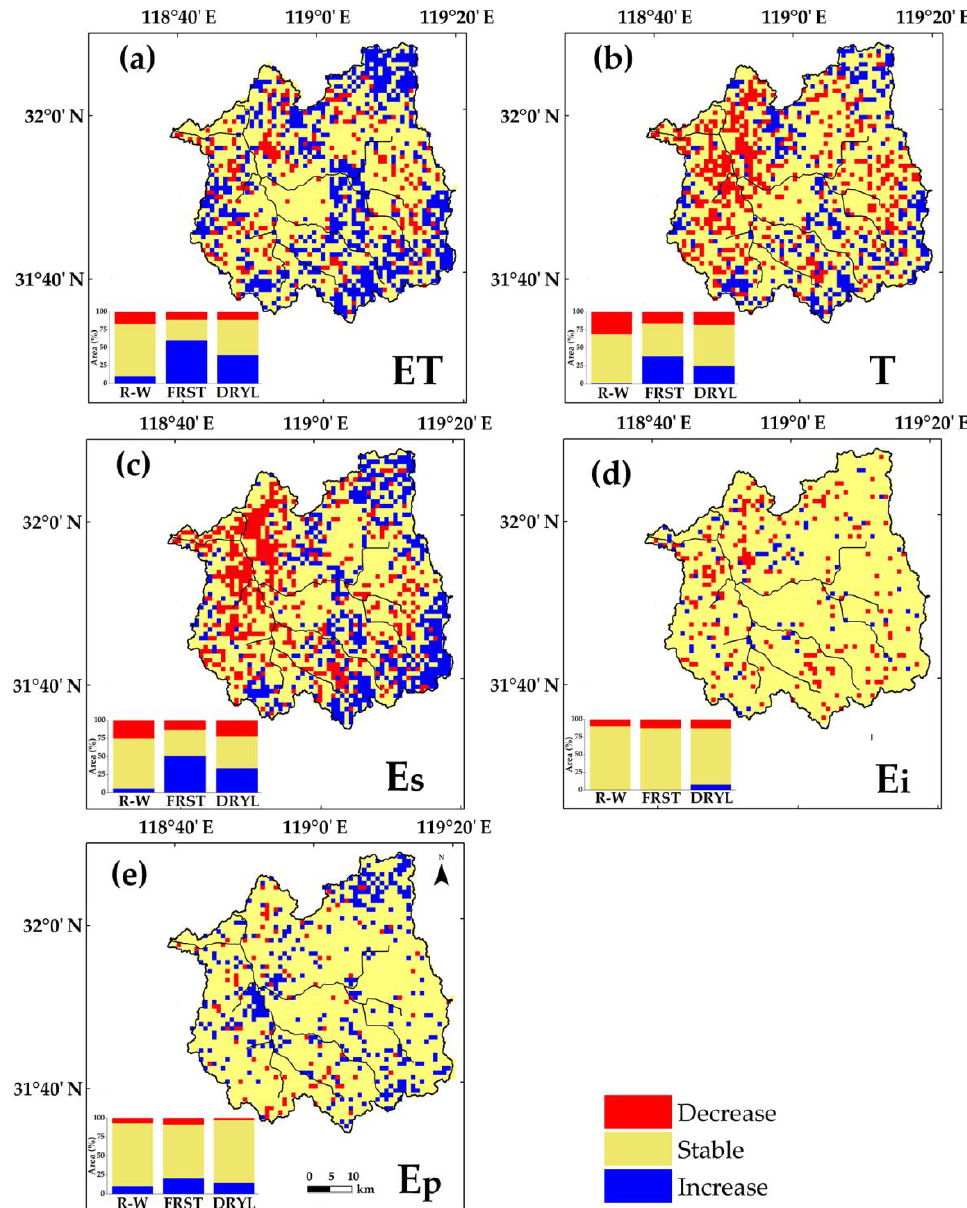
Figure 10. Spatial trends from 2000 to 2013 in: evapotranspiration ET ( a ); transpiration T ( b ); soil evaporation E s ( c ); interception evaporation E i ( d ); and ponded water evaporation E p ( e ). Three distinct areas in ET and components trends are identified as “Increase”, “Stable”, and “Decrease”. The area percentage bars of rice-wheat field (R-W), forest (FRST), and dry land (DRYL) are based on land use in 2000.